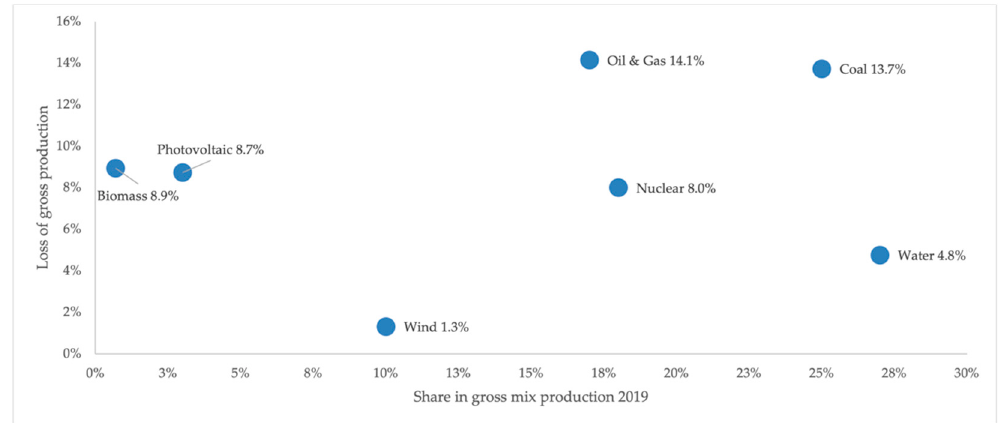
Figure 7. Loss in energy production by type of resources (September 2020), based on [71], using Equation (2).